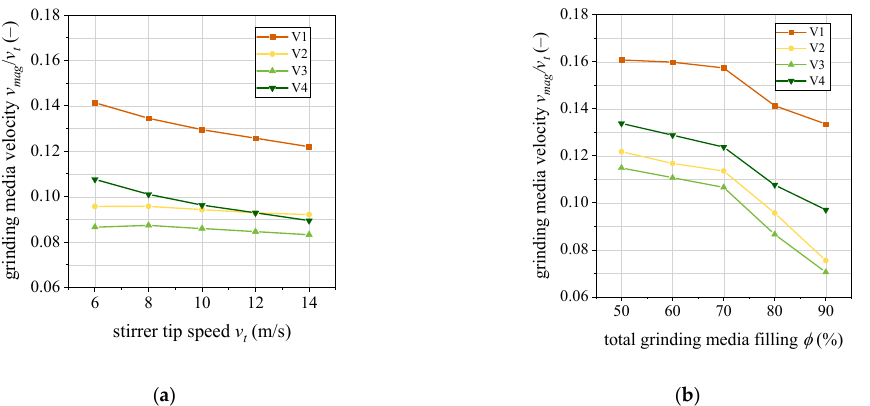
Figure 8. Normalized mean grinding media velocities for volumes V1–V4: ( a ) depending on the stirring disc tip speed at a grinding media filling level φ total = 80%; ( b ) depending on the degree of grinding media filling φ total at a stirrer tip speed of v t = 6 m/s.